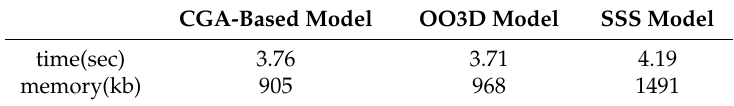
Table 2. The memory requirements and response time in 3D visualization based on